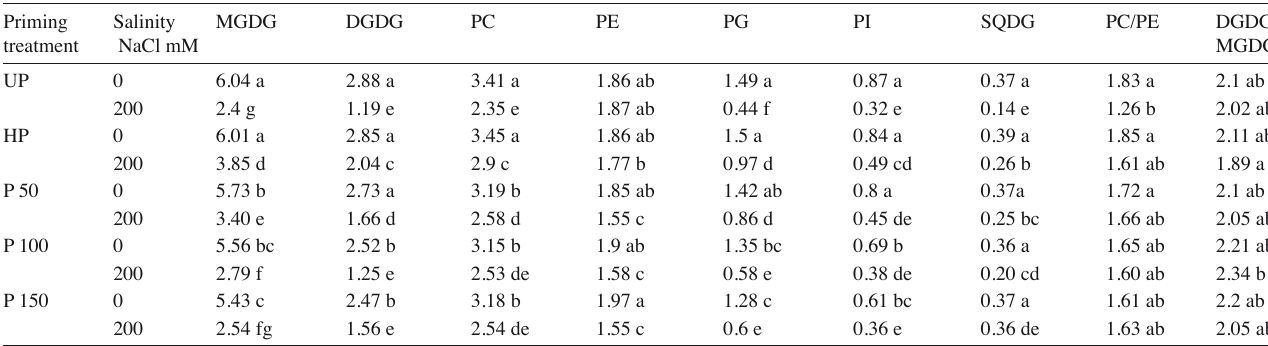
Tab. 4: Lipid classes in shoot seedlings from unprimed and primed rice seeds grown under normal and high salinity. Priming